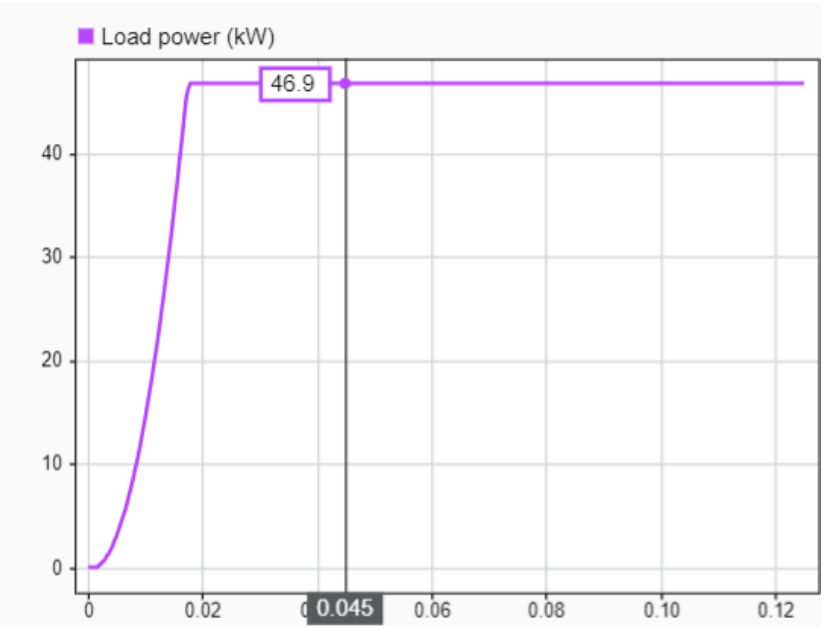
Figure 16. Load power for a supposed delivered power of 48 kW under optimal EPS operation.